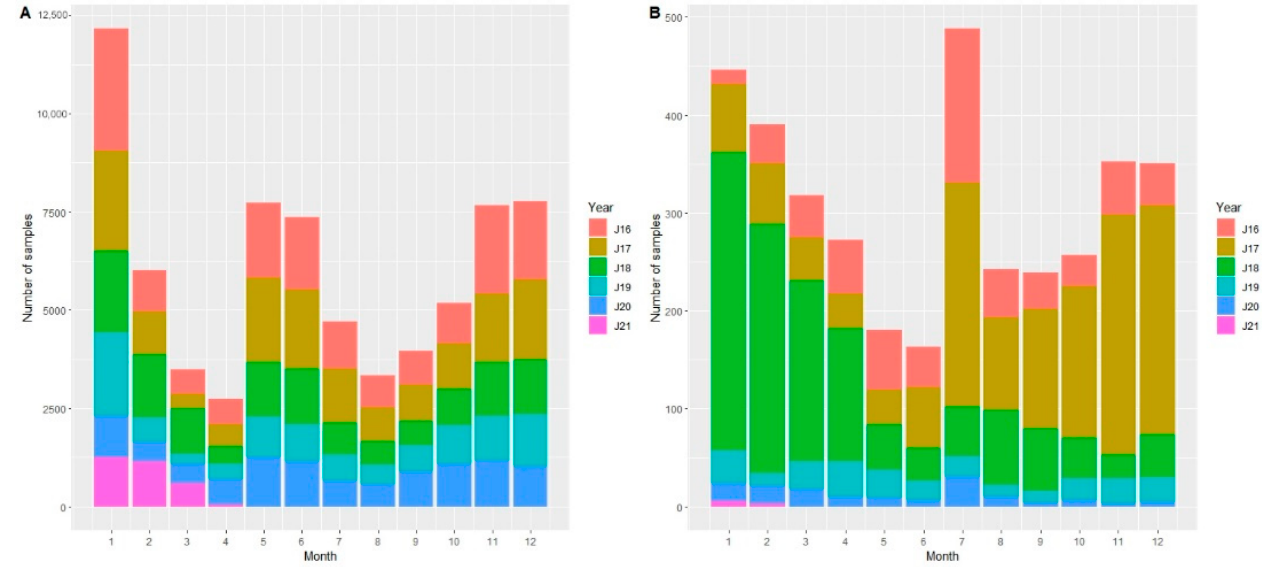
Figure 1. Numbers of samples from hunted wild boar ( A ) and from wild boar found dead ( B ) per month for the years 2016–2021. In 2021, only data from January to 12th April are included.